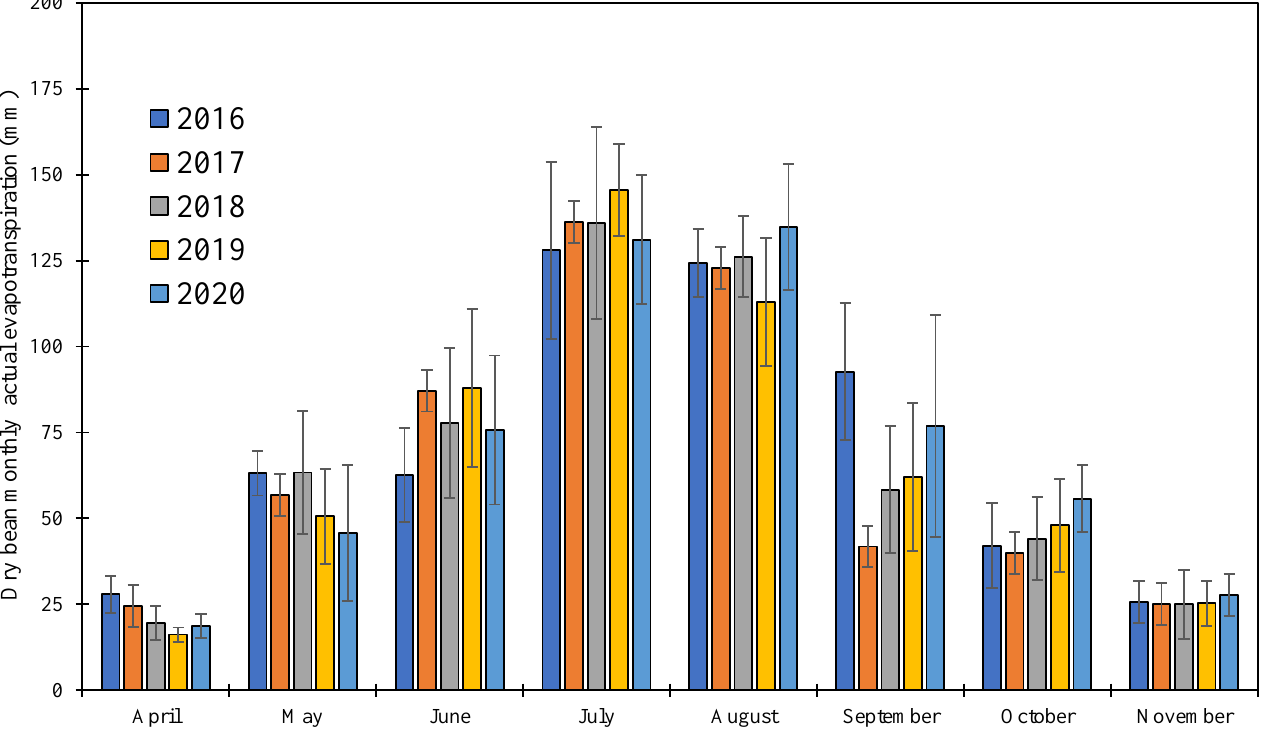
Figure 7. Monthly actual dry bean crop evapotranspiration with standard deviation among twenty- two dry bean fields for the 2016 – 2020 period under center-pivot irrigation.